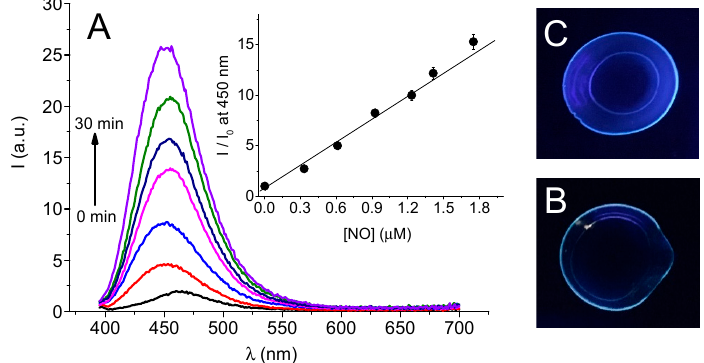
Figure 4. ( A ) Fluorescence emission ( λ exc = 380 nm) spectral changes observed for CL loaded with 1 exposed to daylight at regular intervals of five min. The inset shows the correlation of the fluorescence increase and the concentration of NO released from the CL (I and I 0 represent the fluorescence intensities after and before the irradiation, respectively). ( B ) and ( C ) show the actual fluorescence images of the CL (diameter = 14 mm) observed upon 350 nm of light excitation before and after 30 min exposition of the CL to daylight, respectively.